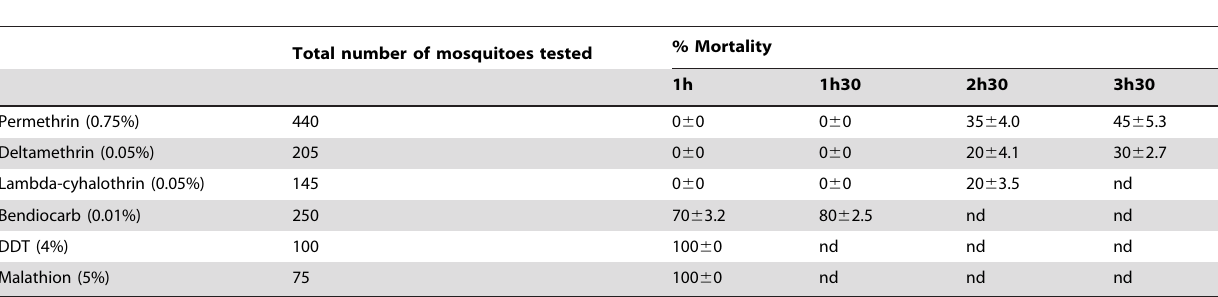
Table 1. WHO susceptibility test results on 1–3 day old F 1 An. funestus from